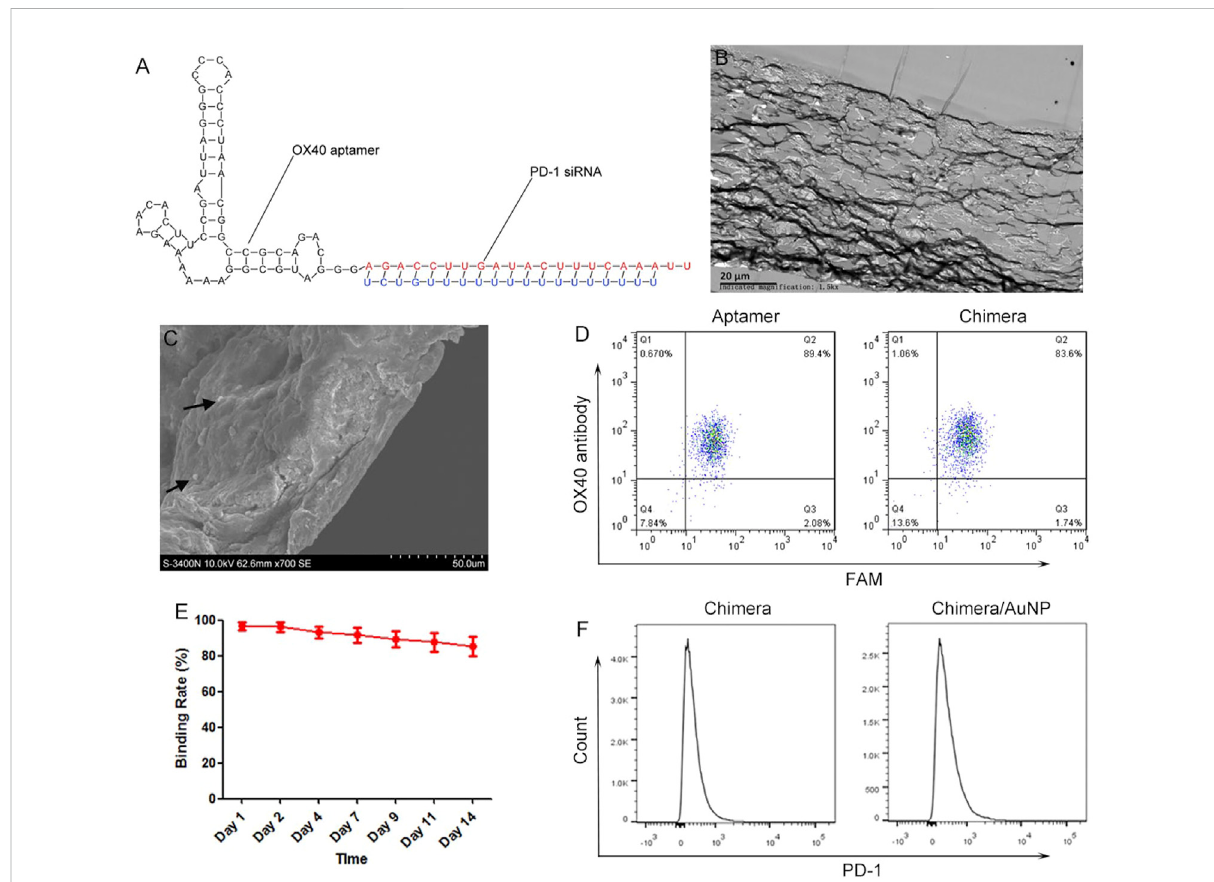
FIGURE 1 Characteristics of aptamer-siRNA chimeras/PEI/PEG/AuNP/collagen membrane (A) Predicted secondary structure for OX40 aptamer-PD- 1siRNAchimera (B) Transmissionelectron microscopeimages (C) Scanningelectronmicroscopeimages (D) WeusedOX40antibodyasthepositive control, and fl ow cytometry results showed that both OX40 aptamer and OX40 aptamer-PD-1 siRNA chimera could bind to OX40 + cells with high speci fi city (E) Releaseexperimentsshowedthatchimeras/PEI/PEG/AuNP/collagenmembranecouldcontrolthereleaseofchimerasforatleast 2 weeks (F) Both OX40 aptamer-PD-1 siRNA chimera and chimera/AuNP signi fi cantly inhibited the expression of PD-1. Chimeras/PEI/PEG/AuNPs progressively activated T cells in malignant pleural